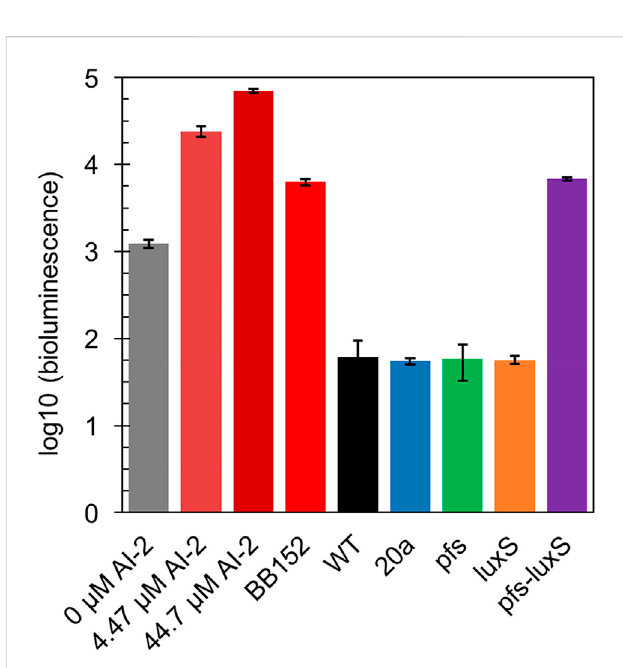
FIGURE 3 Bioluminescence assay by V. fi sheri BB170 for AI-2 semi- quanti fi cation in the supernatant of